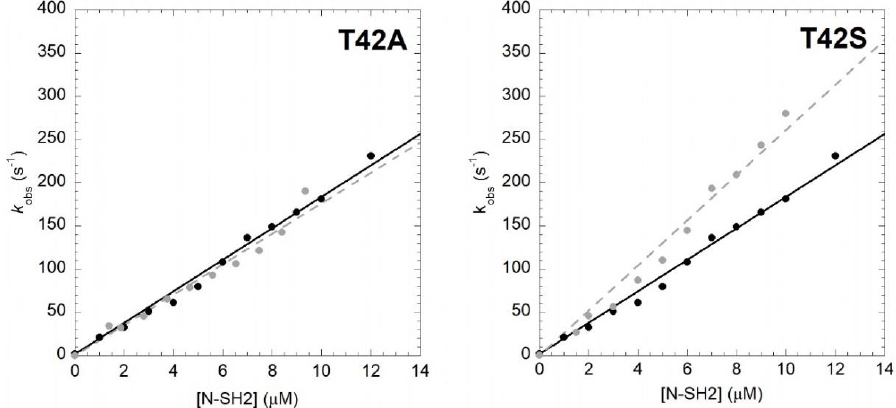
Figure 1. Kinetics of binding between Gab2 608 − 620 and N-SH2 wt (black circles, black continuous line) and its variants (gray circles, gray broken lines) in bu ff er Hepes 50 mM pH 7.2, NaCl 300 mM, at 10 ◦ C. wt data were taken from [17]. Lines are the best fit to a linear equation.